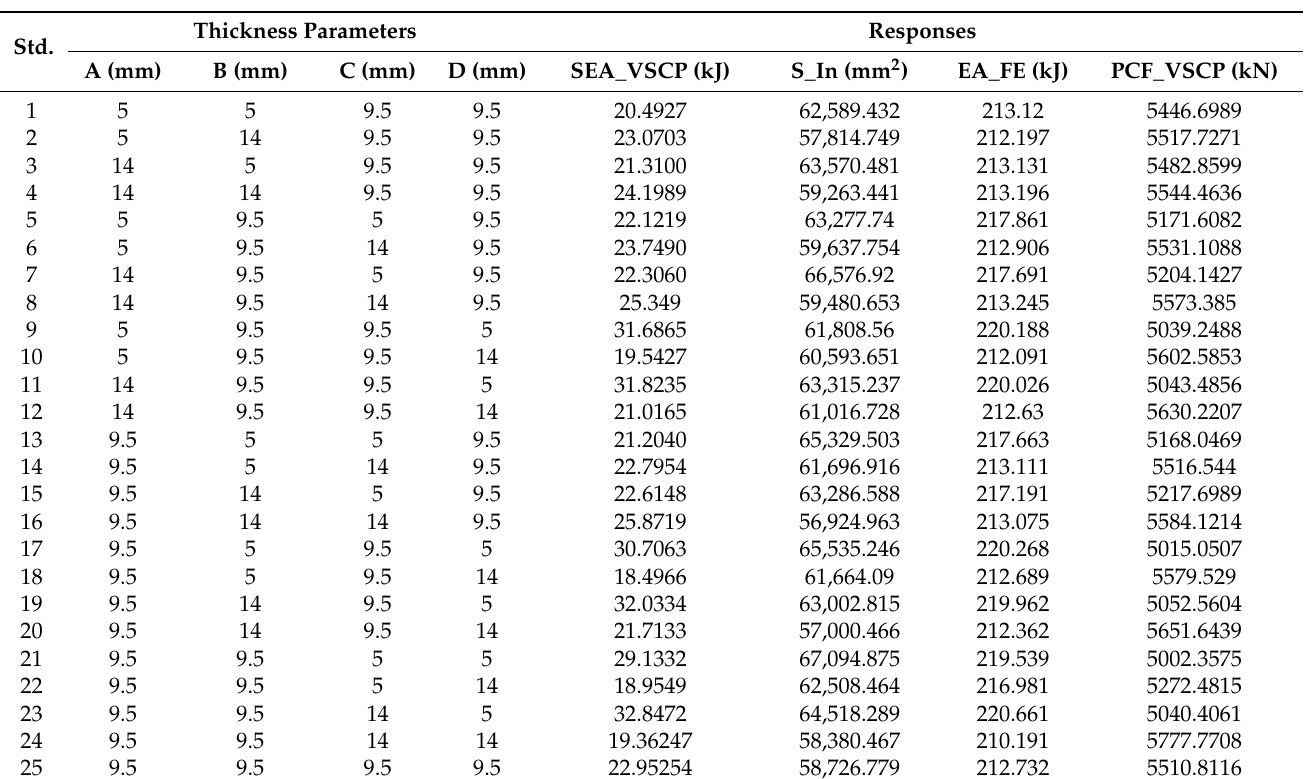
Table 4. Design of experiment and simulation results of